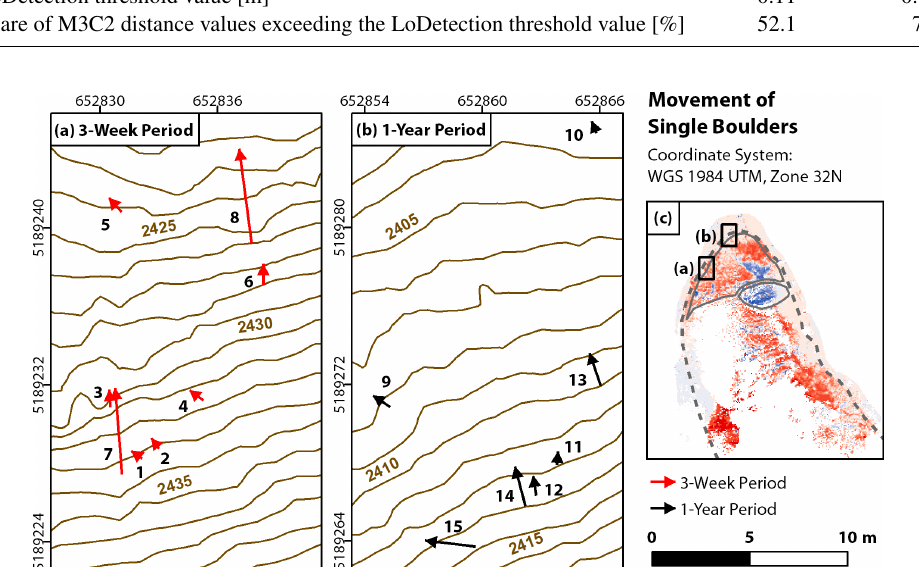
Figure 5. Movement of single boulders in two different subareas of the rock glacier front during the 3-week period (a) and the 1-year period (b) . Boulders are predominantly moving in the direction of rock glacier flow. The distances covered by the moving boulders range from few centimeters to 6m during the 3-week period, enabling a clear distinction between creep-induced boulder movement (boulders 1 to 6) and gravity-induced boulder movement (boulders 7 and 8). During the 1-year period, the magnitudes of the detected single boulder movements are more homogeneous than during the 3-week period and remain well below 5m, indicating that all of these boulders undergo creep-induced